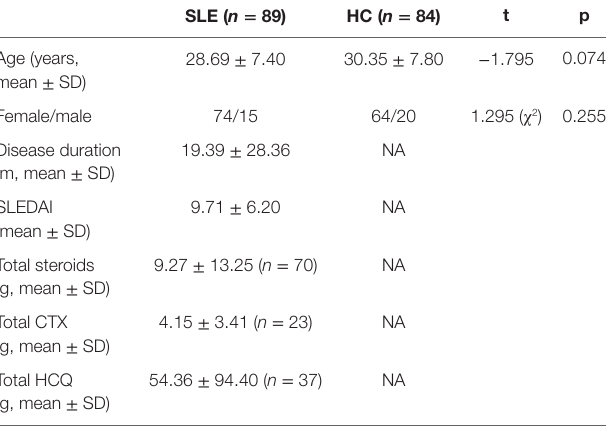
TaBle 1 | Demographic and clinical characteristics of SLE and HC